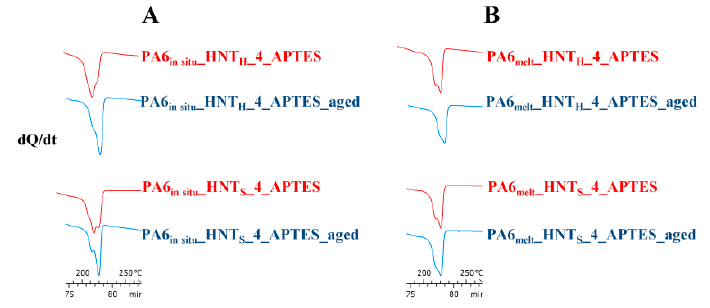
Figure 8. Heating scans of ( A ) PA6 in situ _HNT, and ( B ) PA6 melt _HNT nanocomposites prepared with the 4% w / w of modified HNT before and after the ageing test.